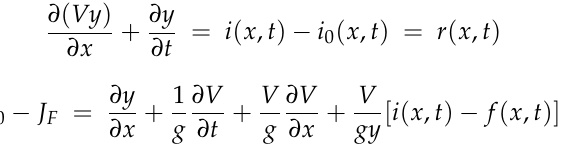
Figure 3. The model built according to the two situations, ( a ) No vegetation restoration, ( b ) High-level vegetation restoration. Table 1. The land-use patterns and vegetation coverage in the Kangjiagelao watershed. Land-Use Pattern